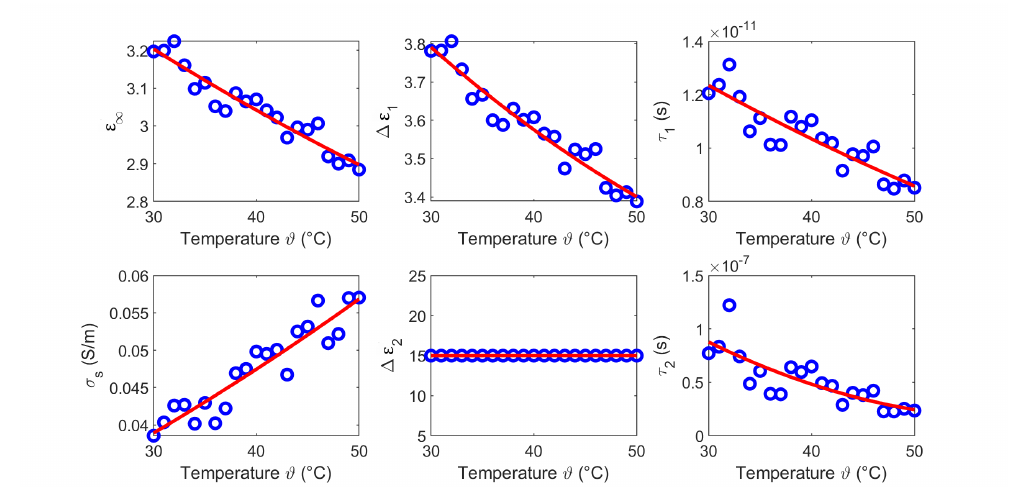
Figure 13. Temperature dependent Cole-Cole parameters (blue circles) of fat and the corresponding second order polynomial fit (red